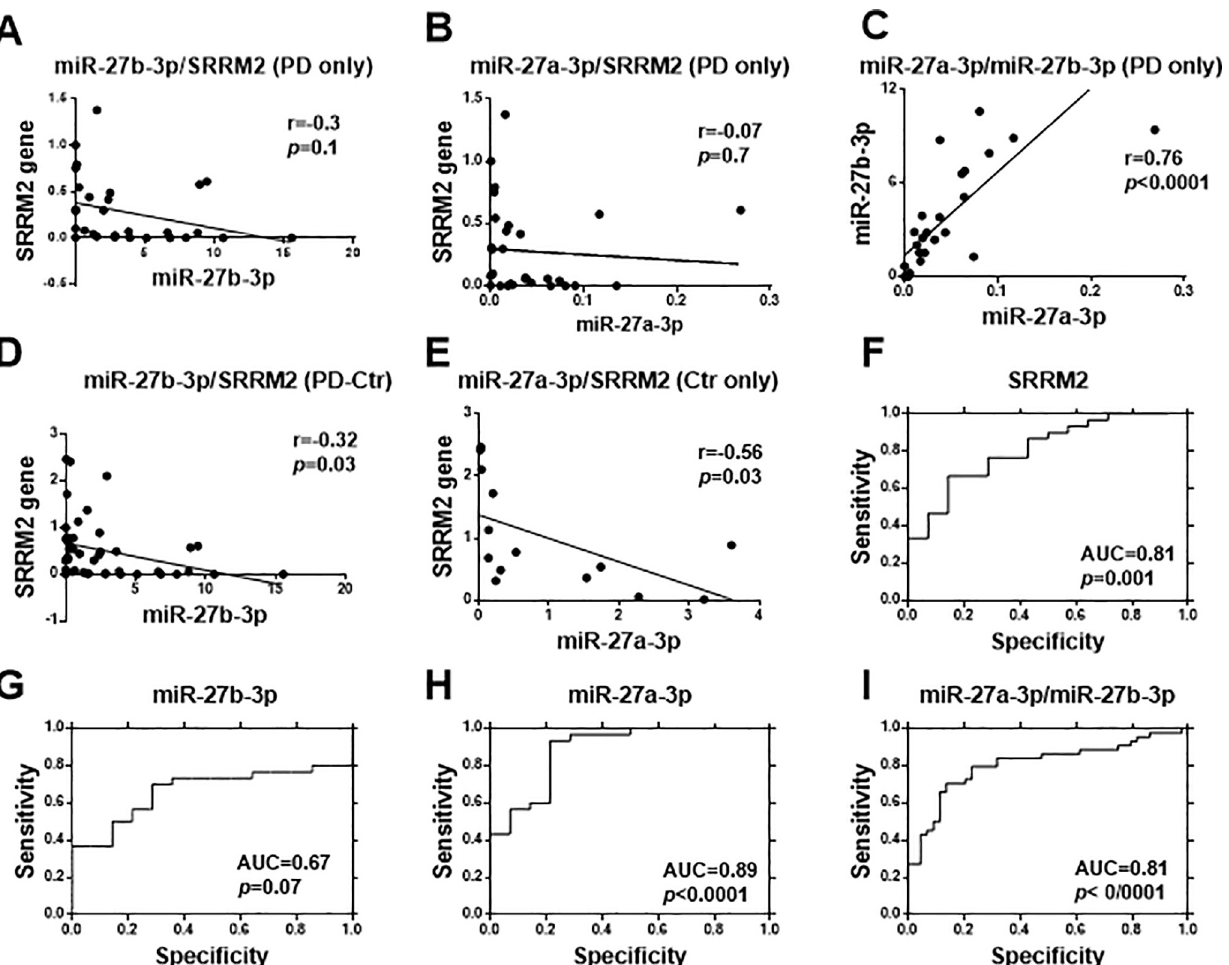
Fig 5. Correlation between SRRM2 and miR-27a/b-3p levels, and their ROC curve. SRRM2 expression correlate with (A) miR-27b-3p and (B) miR-27a- 3p in PD patients, respectively. (C) miR-27a-3p and miR-27b-3p expressions correlate with together in PD patients. These accuracy for detection ability of PD were determined using the ROC curve. (D) Correlation between SRRM2/miR-27b-3p in PD patients vs. controls and (E) correlation between SRRM2/ miR-27a-3p in healthy controls were presented. Their AUC were (F) 0.81 (95% CI: 0.57–0.98, p = 0.001), (G) 0.89 (95% CI: 0.5–0.95, P < 0.0001), (H) 0.67 (95% CI: 0.57–0.98, p = 0.07) and (I) 0.81 (95% CI: 64.7–90.2, p < 0.0001). Data about correlations were analyzed by Pearson’s correlation coefficient r and linear regression, with p -values are shown in the graphs. A summary of the correlation results in S1 Table and results of the ROC curve are presented in S2 Table. Abbreviations: Ctr = Control; PD = Parkinson disease. using the PathwayNet website (S2 Fig) was drawn. The genes that participate in the mitochon- drial function and splicing processes had higher relationship confidence, such as TCP-1 α ,